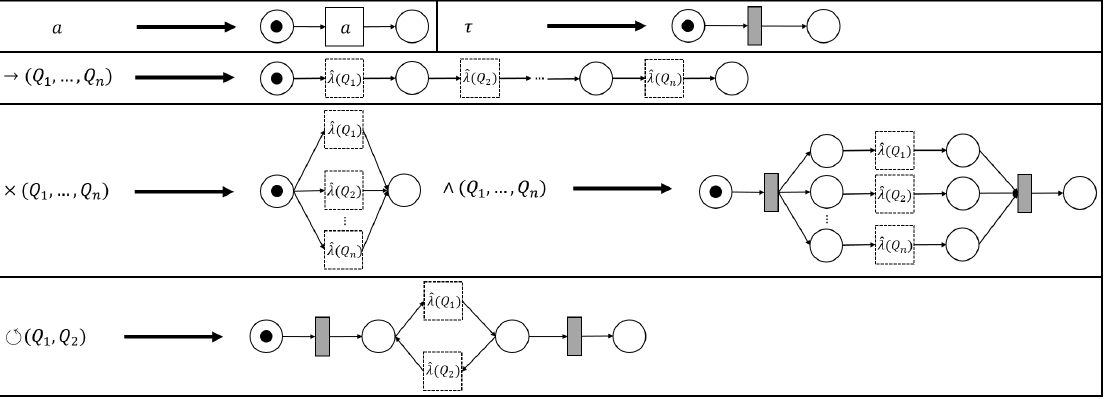
Figure 5. Instantiations of λ (5). The λ -functions for operators are defined recursively, using the ˆ λ -values of their children, i.e., a place “entering”/“exiting” a ˆ λ ( Q (respectively) of λ ( Q i )